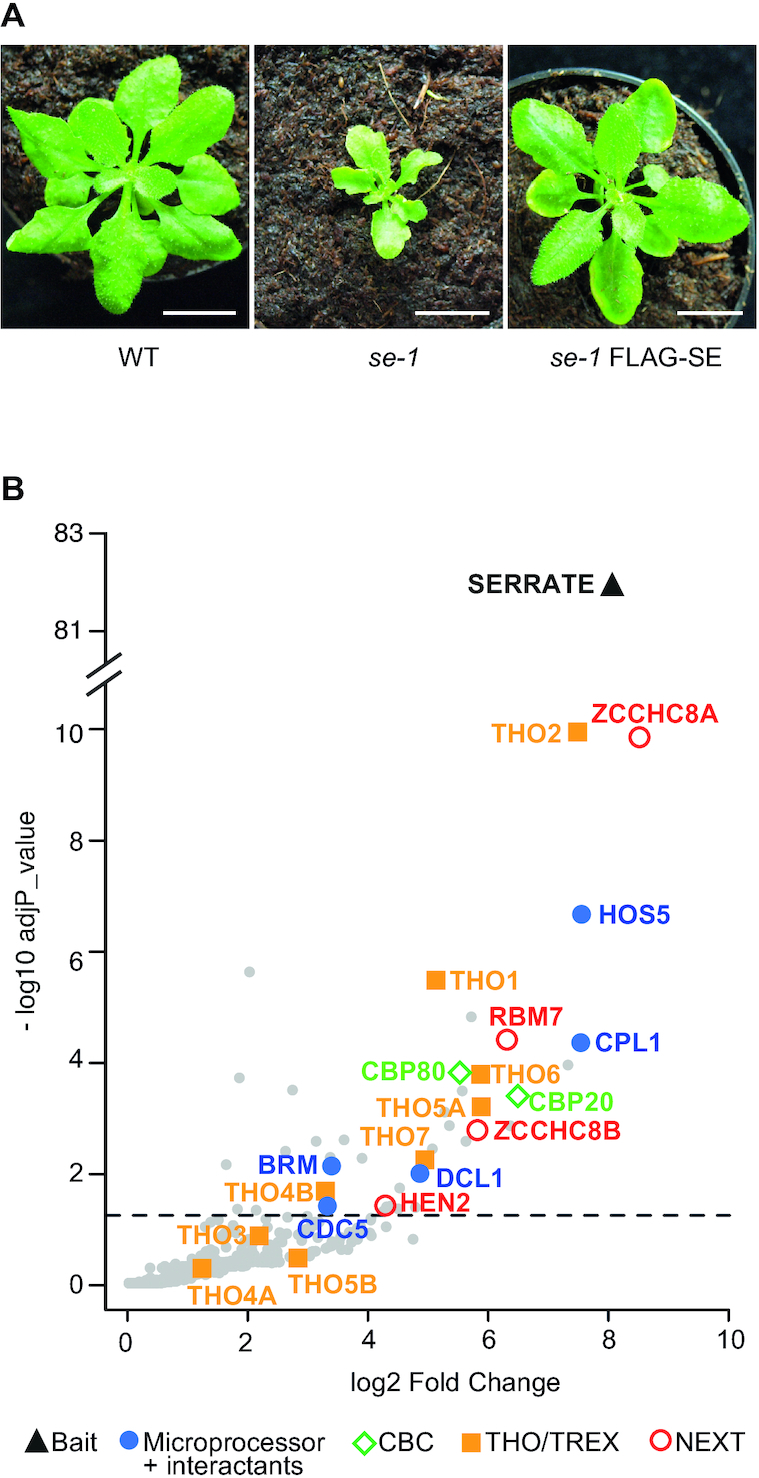
Proteins associated with Arabidopsis SERRATE. (A) Phenotypes of 4 week-old WT, se-1 and se-1 plants expressing an FLAG-SE. Scale bars are 1 cm. (B) Volcano plot showing the proteins co-purified with FLAG-SE as compared to control IPs performed in Col-0. The bait SE is indicated by a triangle. Closed circles label the proteins known to compose or interact with the Arabidopsis Microprocessor complex, diamonds label the two subunits of the CBC, squares label the subunits of the THO/TREX complex and open circles label the subunits of the NEXT complex. The dashed line indicates the significance threshold (adjp < 0.05).